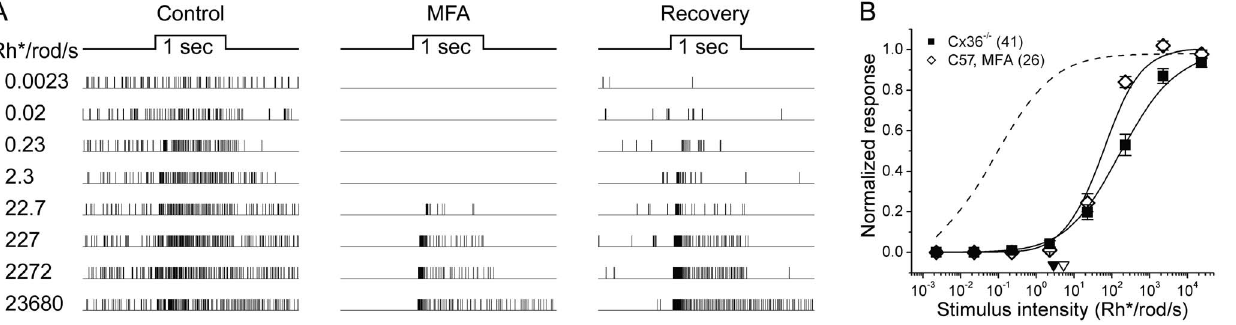
Figure 4. Pharmacological blockade of gap junctions mimics Cx36 knockout, reducing sensitivity of synaptic input to ipRGCs. A : Raster plots of the response of a single ipRGC in a wildtype mouse (C57Bl6) to 500 nm light steps recorded before (left), during (middle) and after (right) bath application of MFA, a gap junction blocker. Stimuli increased in intensity by , 1 log unit with each trial, shown in successive rows of the raster. MFA application abolished the light response to dim stimuli and elevated threshold by about 3 log units; spontaneous activity was also much reduced. Sensitivity largely recovered upon washout of the drug. B : Group data comparing irradiance-response functions ipRGCs recorded in MFA- treated wildtype mouse retina (n=26) with those recorded in Cx36 knockout mice (n=41). The triangles near the abscissa indicate the response thresholds (open triangle, C57Bl6, MFA; filled triangle, Cx36 2 / 2 ). The dashed curve, is reproduced from Fig. 2B, permits comparison with C57Bl6 mice under control conditions. The reduction in light sensitivity was comparable in these two manipulations, supporting the view that the effect is due in both cases to loss of synaptic circuits that are dependent upon gap junctions rather than to off-target genetic or drug effects.